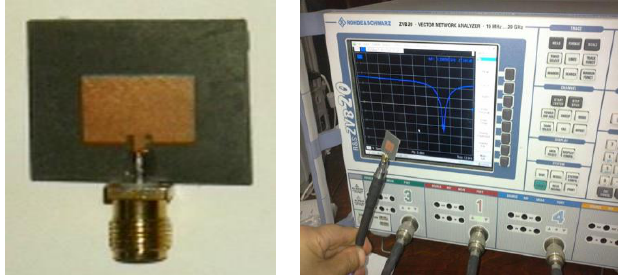
Figure 2: Fabricated microstrip antenna operates at 10 GHz and its measurement